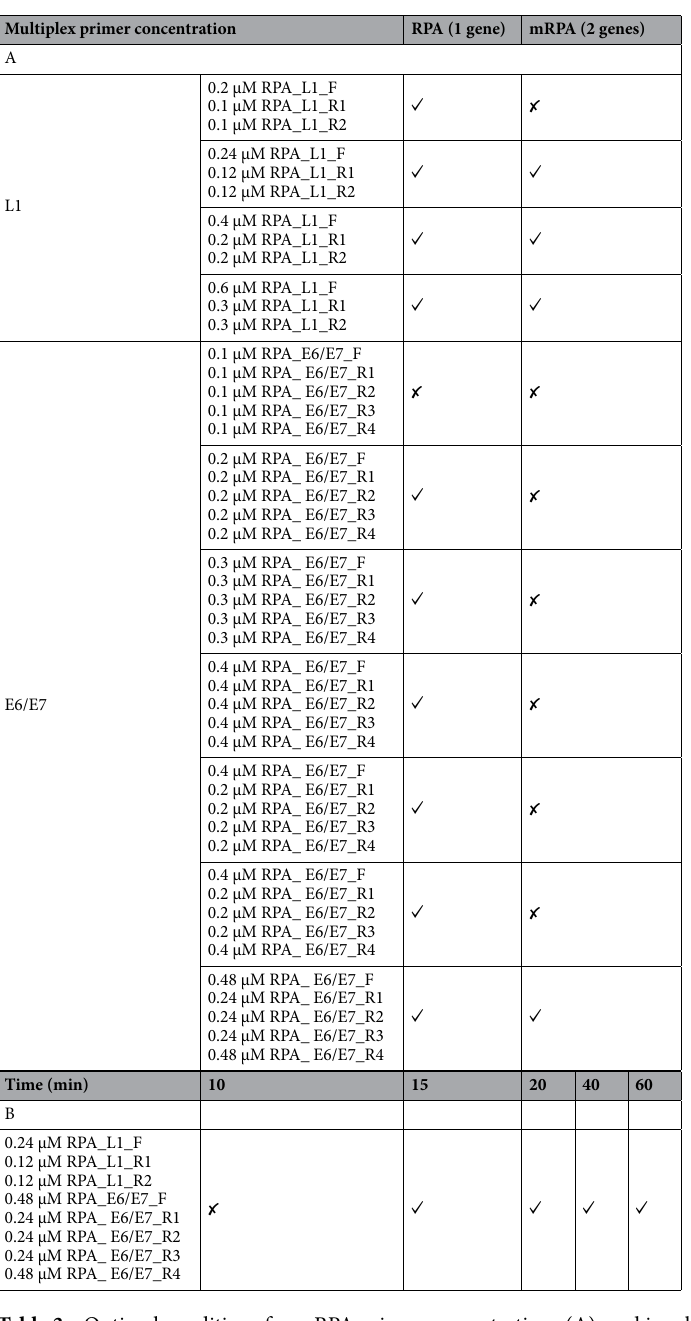
Table 3. Optimal conditions for mRPA primer concentrations (A), and incubation time